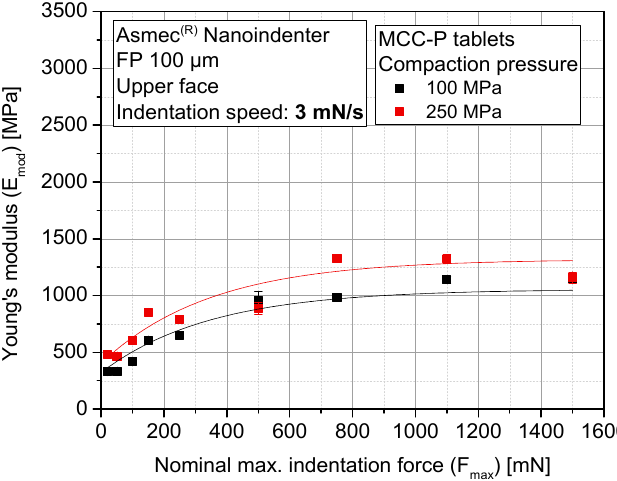
Figure 8. Median elastic modulus of MCC-P tablets as a function of the maximum indentation force for different nominal compaction pressures ( n = 79 for each compaction pressure (CP) and indentation force).